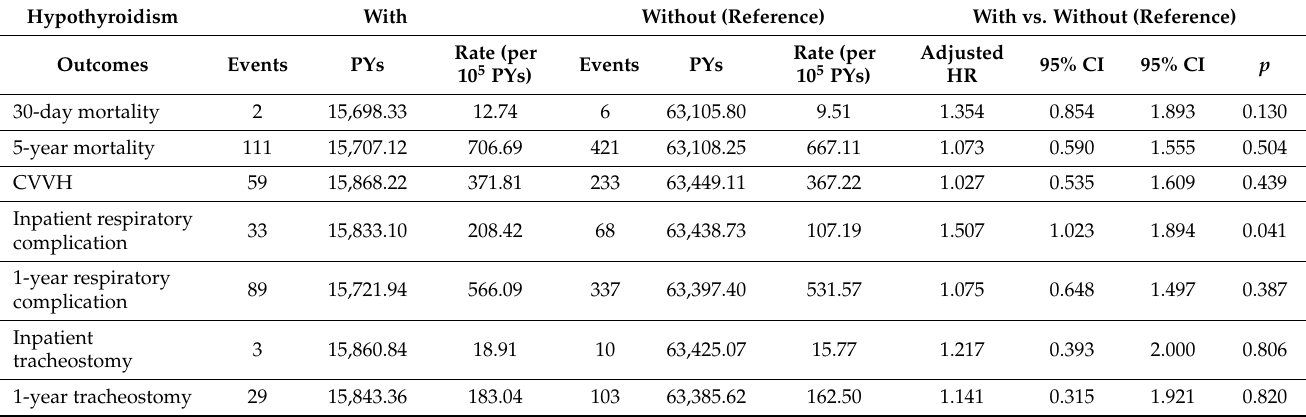
Table 4. Rate of